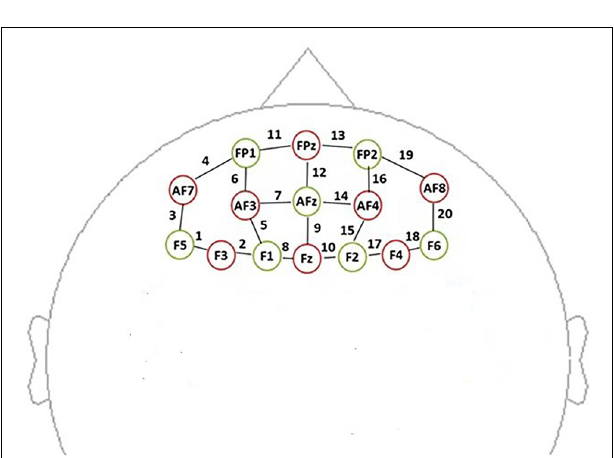
FIGURE 2 | Schematic representation of the visual food cue paradigm procedure. C indicates control; L, low-calorie food; H, high-calorie food; and +, fixation cross.